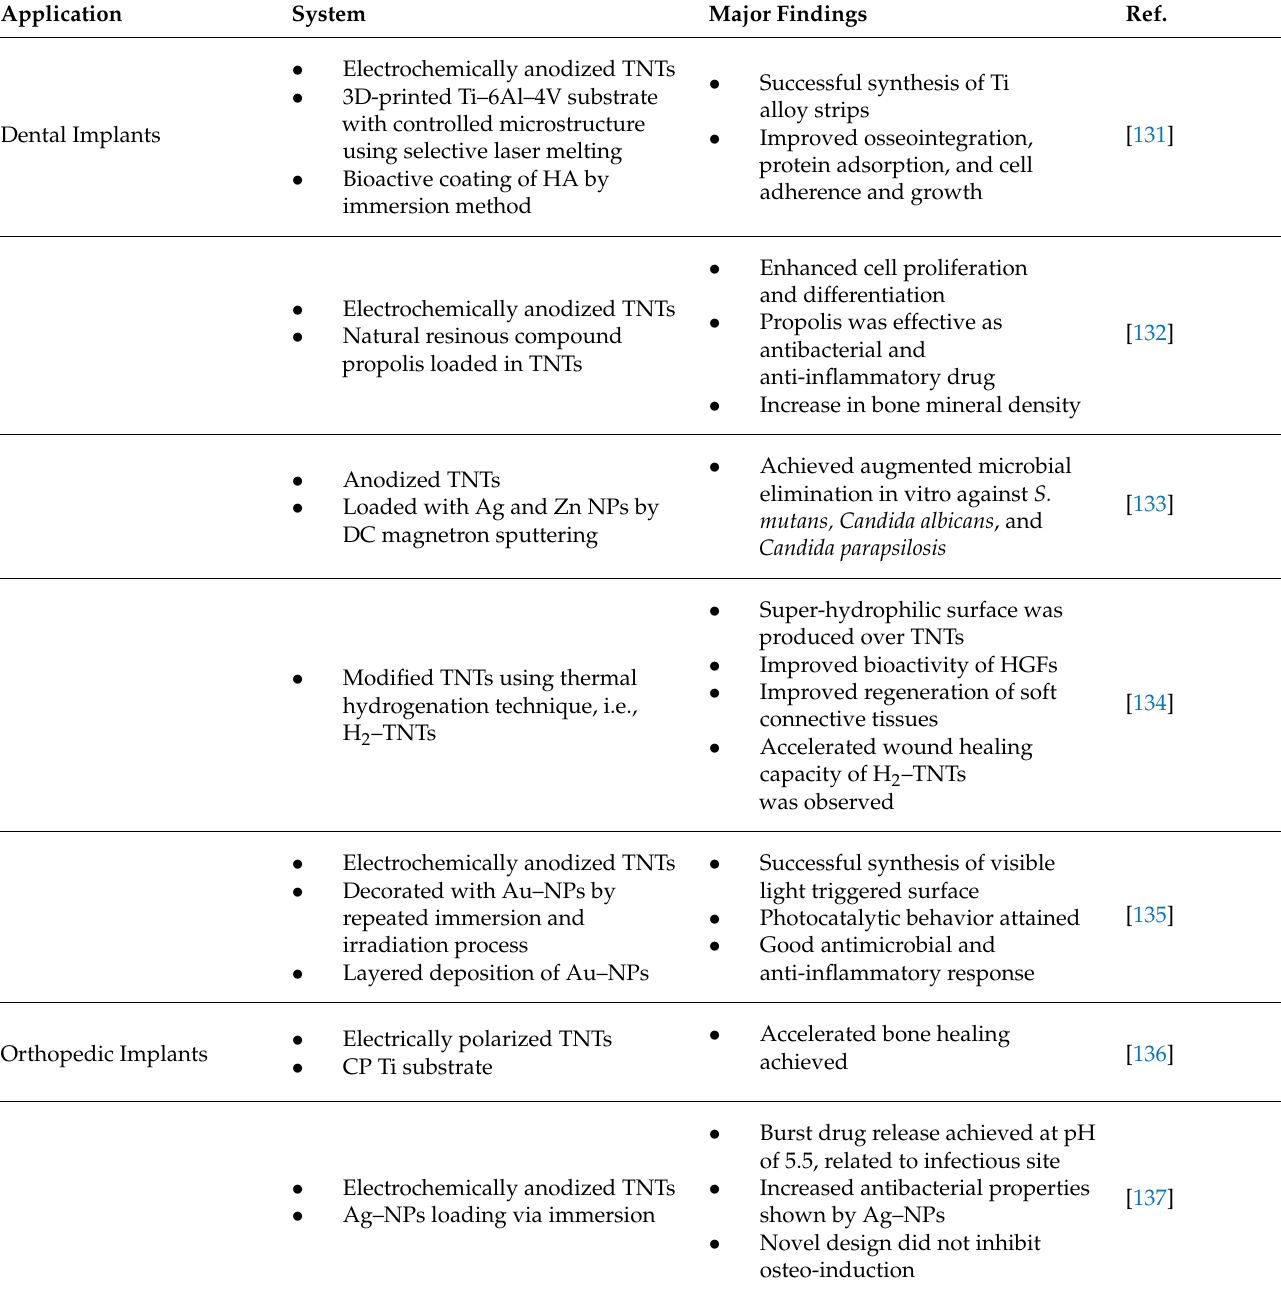
Table 2. TNTs application in dentistry and orthopedic